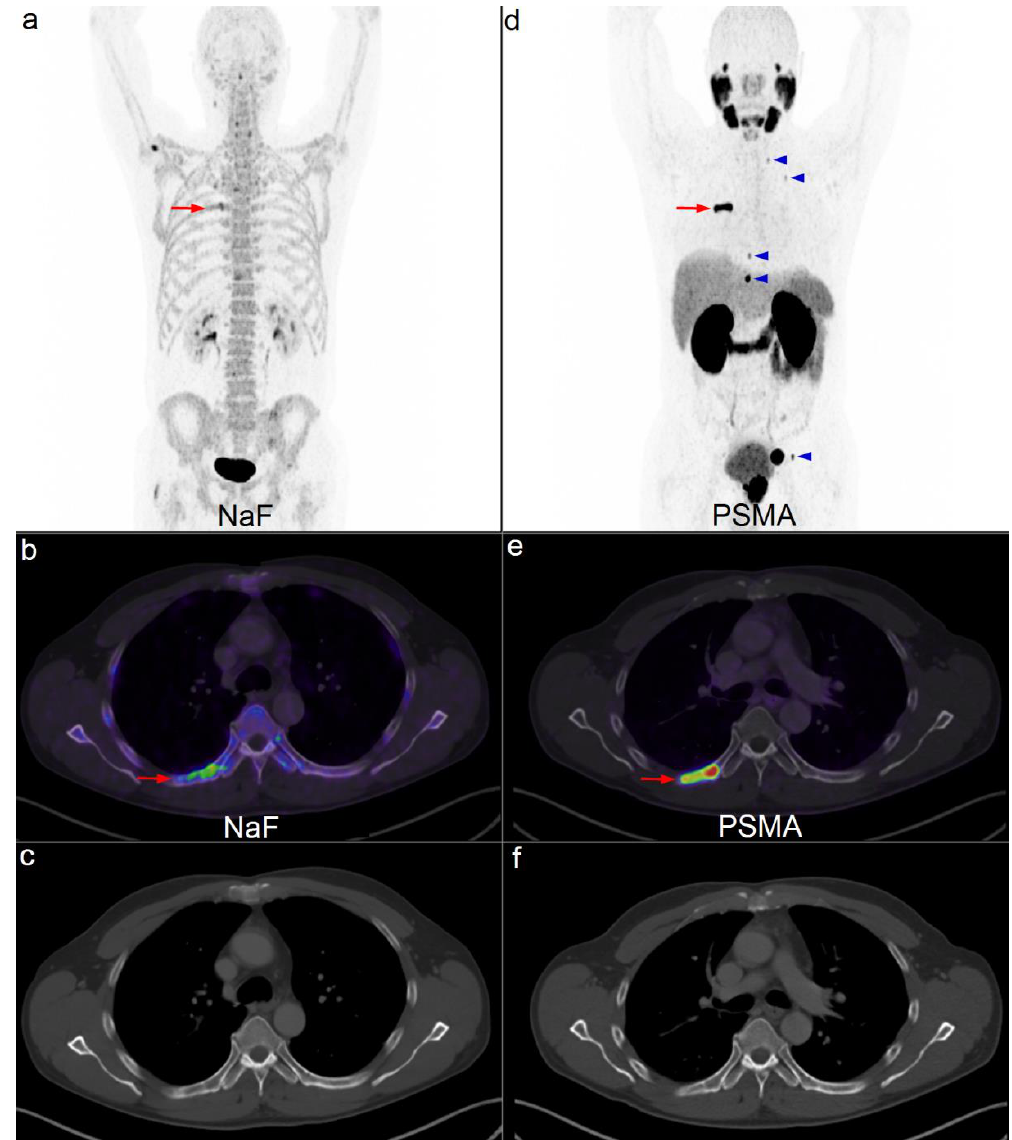
Figure 2. Example of a patient referred for 18 F-NaF PET/low-dose CT for primary staging. An irregular lesion with faint uptake ( red arrow ) is visible on 18 F-NaF PET/CT ( a and b ). Corresponding CT shows small, unspecific sclerotic areas ( c ). Subsequent 68 Ga-PSMA PET/CT ( d and e ) shows intense uptake ( red arrow ). Several additional bone lesions with increased uptake are visible on maximum intensity projection (MIP) ( d ) ( blue arrowheads ). The corresponding CT is unchanged ( f ). PSMA MIP ( d ) also shows increased uptake in the prostate and in an enlarged lymph node in the left side of the pelvis.